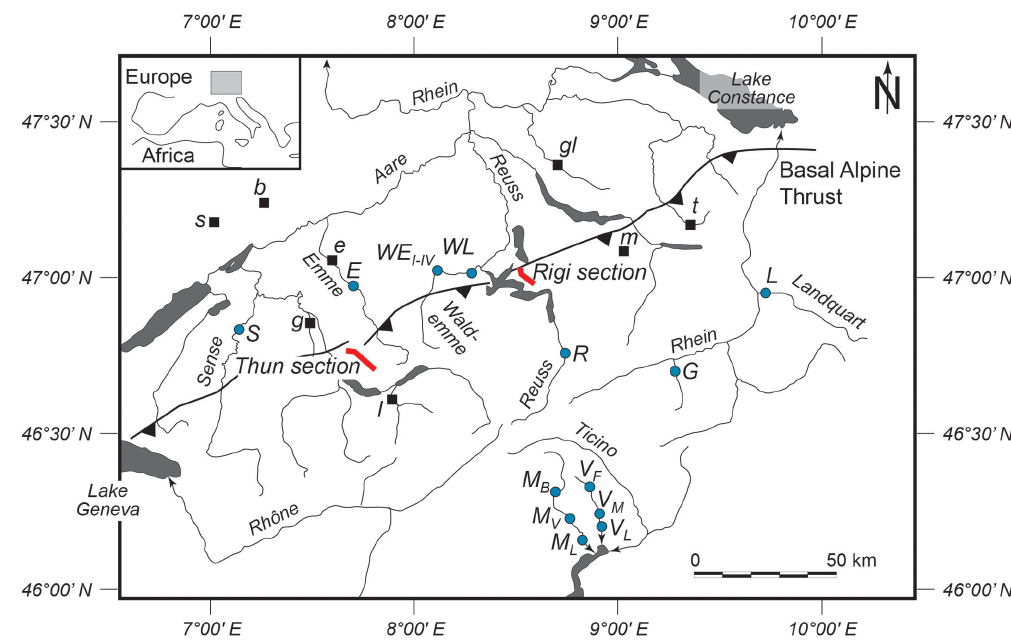
Figure 2. Sites where modern gravel bars in streams were inspected for the occurrence of clast imbrication (blue dots). The figure also shows the locations of the stratigraphic sections where conglomerates were analyzed for their sedimentary structures. S : Sense; E : Emme; WE I − IV : Waldemme; WL: Waldemme at Littau; R : Reuss; L : Landquart; G : Glenner; M B , M V and M L : Maggia at Bignasco, Visletto and Losone; V F , V M and V L : Verzasca at Frasco, Motta and Lavertezzo. See Table 1 for coordinates of sites. The black squares are sites where Spreafico et al. (2001) have estimated channel gradients and Froude numbers for low- and high-stage flows. b : Birse-Moutier, e : Emme- Burgdorf, gl : Glatt-Fällanden, g : Gürbe-Belp, m : Minster-Euthal, l : Lütschine-Gsteig, s : Suze-Sonceboz, t :